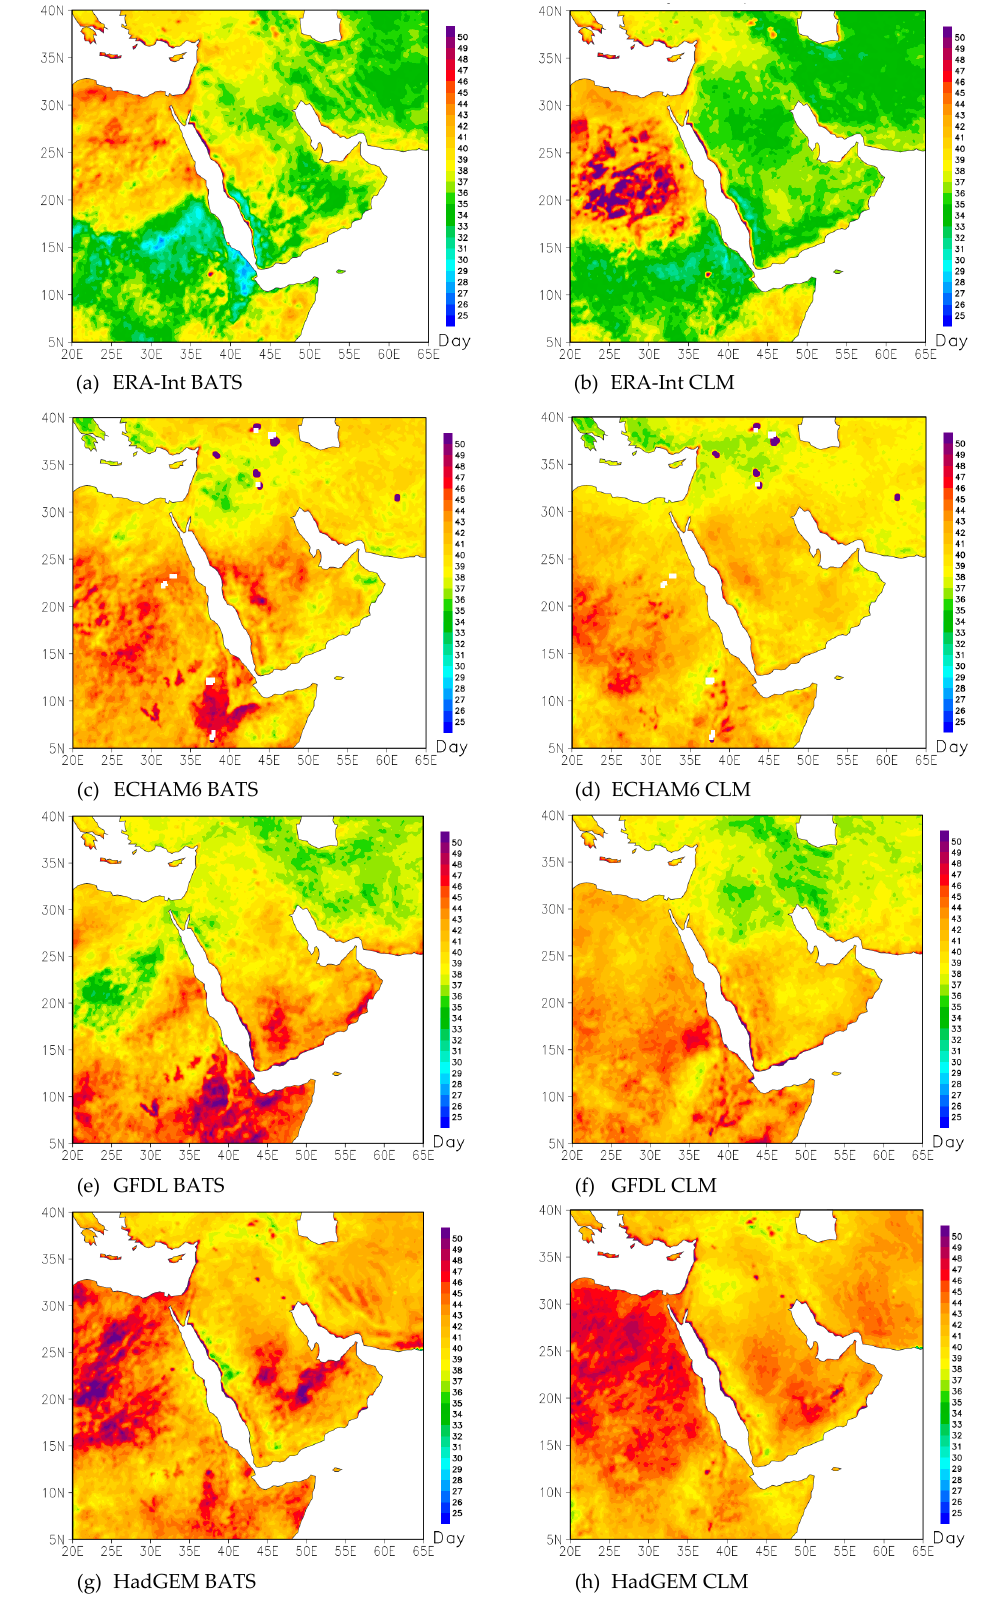
Figure 5. Spatial distribution of annual warm nights (TN90p) for ( a ) ERA–Int BATS, ( b ) ERA–Int CLM, ( c ) ECHAM6 BATS, ( d ) ECHAM6 CLM, ( e ) GFDL BATS, ( f ) GFDL CLM, ( g ) HadGEM BATS, and ( h